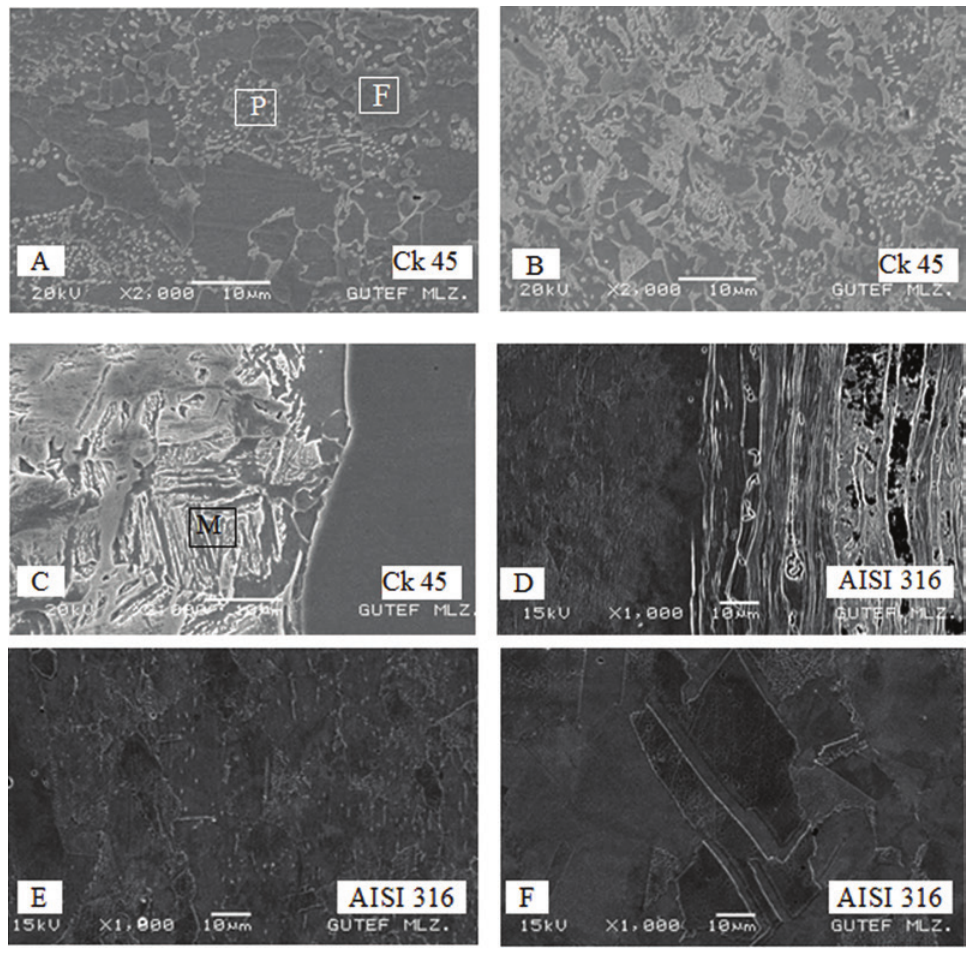
Fig. 7: FESEM microstructures of welded specimen in the different zones